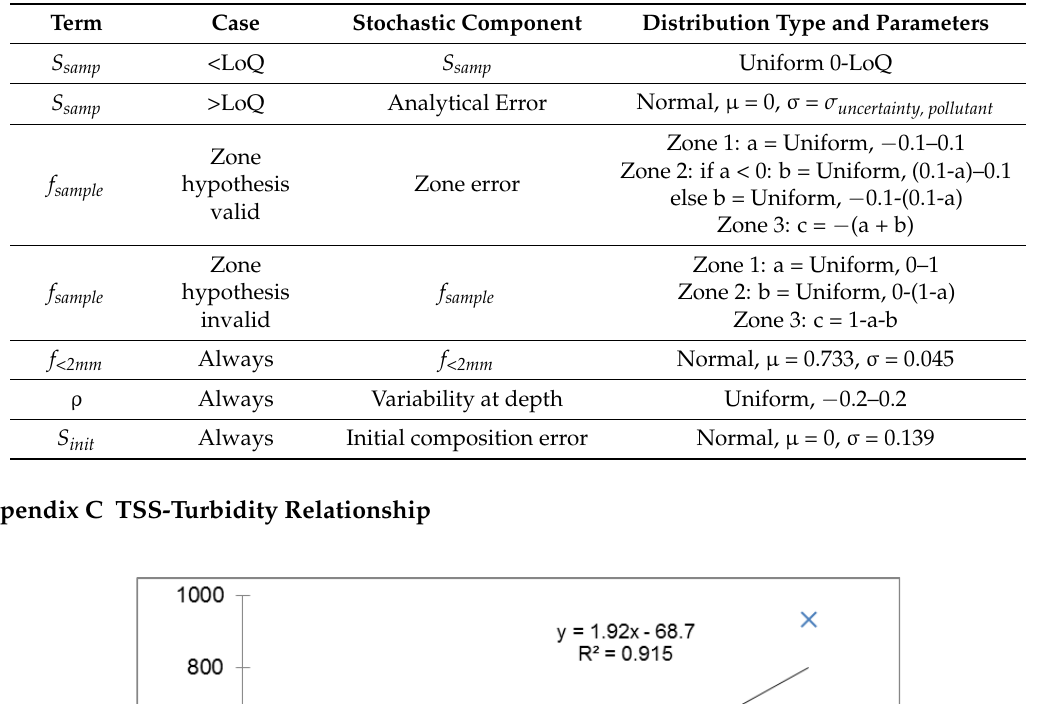
Table A5. Summary of distributions used for calculating masses of pollutants in the soil.